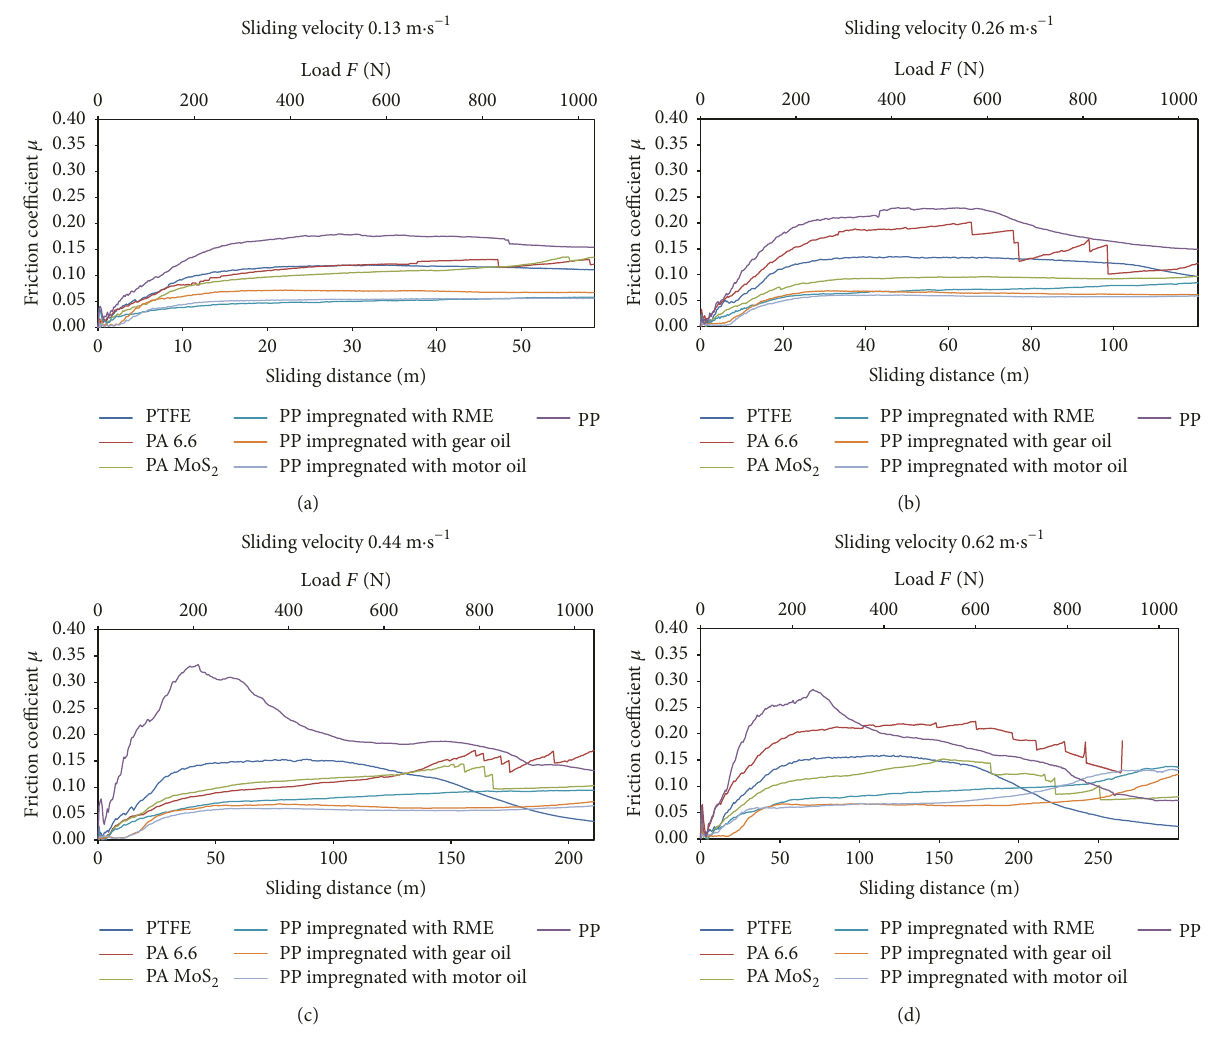
Figure 3: Relationship between sliding distance, load, and friction coefficient of the specimens at various sliding velocities: (a) 0.13, (b) 0.26, (c) 0.44, and (d) 0.62 m ⋅ s −1